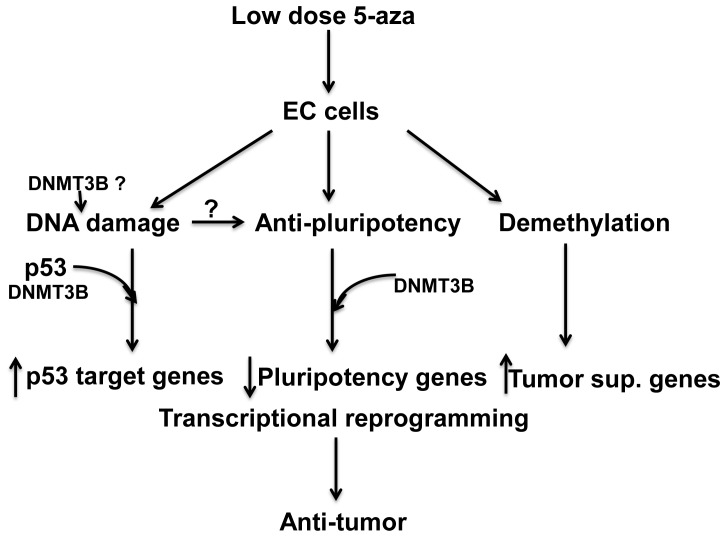
Model of mechanisms of low-dose 5-aza hypersensitivity in EC cells.Low dose 5-aza effects on EC cells are multifactorial and include induction of DNA damage, p53 activation, DNA promoter demethylation, and repression of pluripotency genes. Proposed DNMT3B-dependent effects based largely on microarray analysis is indicated along with speculative role of DNMT3B in altering composition of DNA adducts. Prior direct repression of pluripotency factors by DNA damage is not supported by the current study.